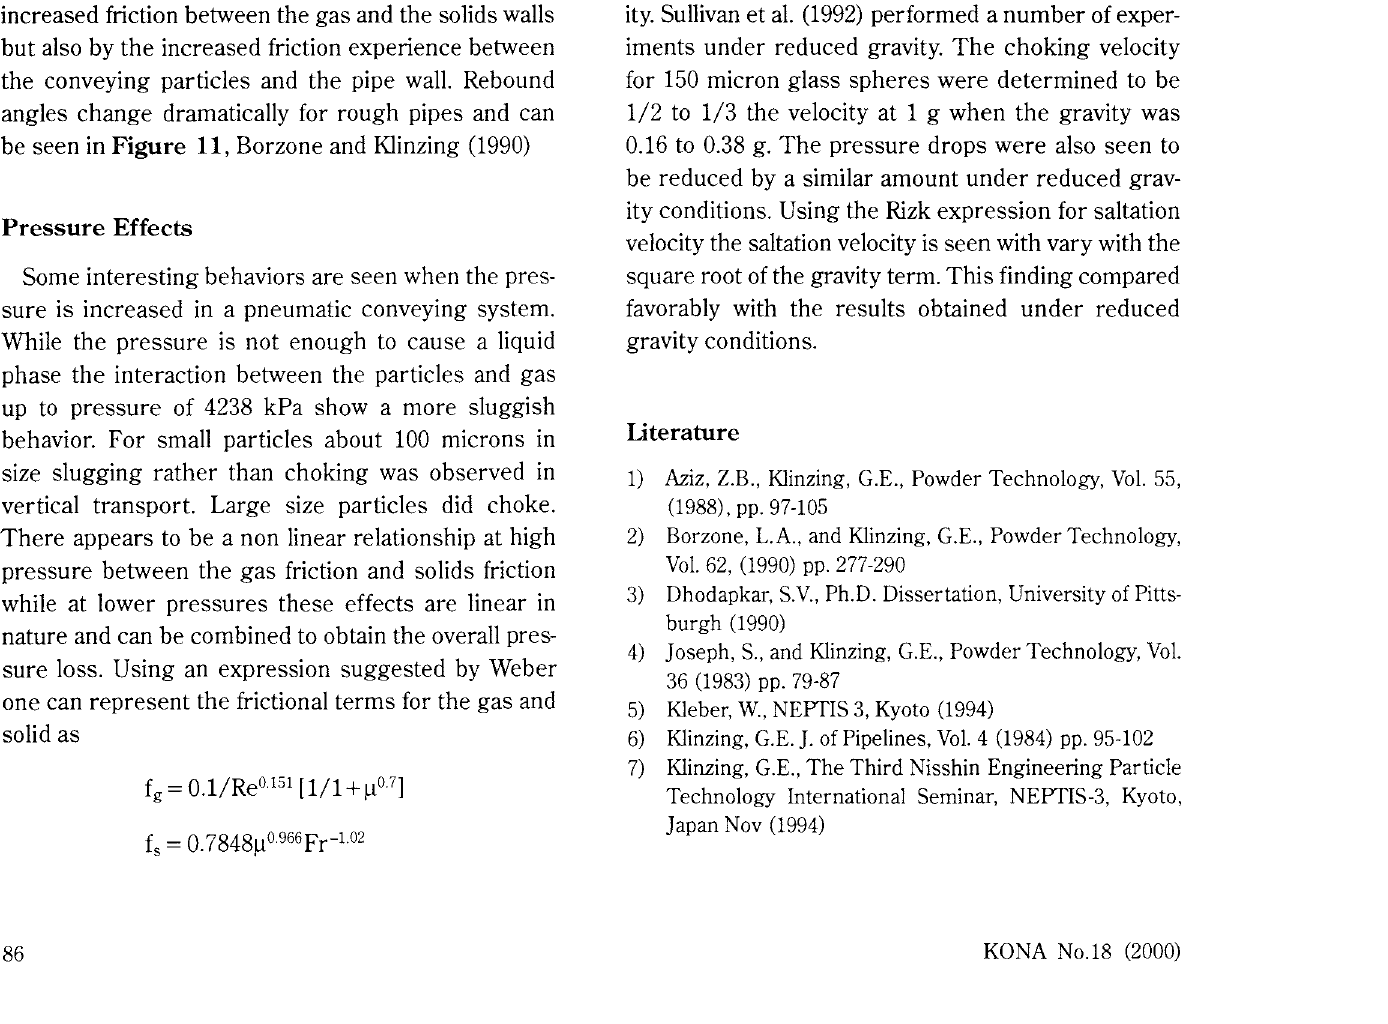
Fig. 11 Solids dispersion upon impact. (a), Smooth wall; (b) rough